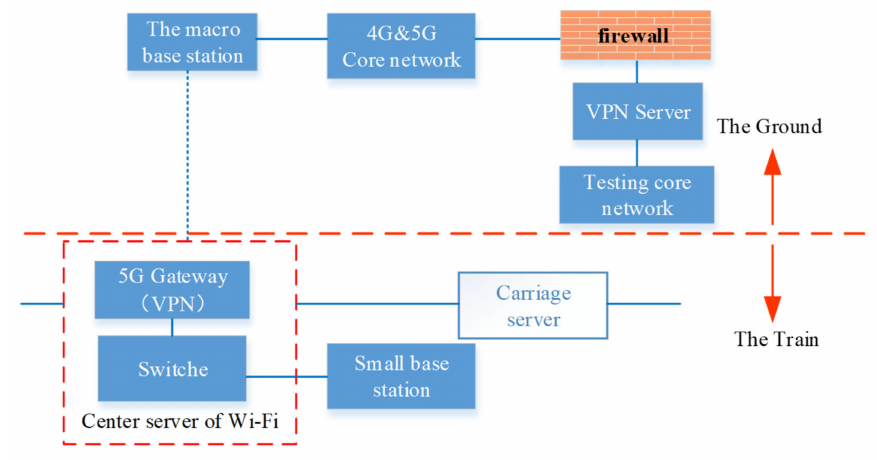
Figure 7. Testing architecture.